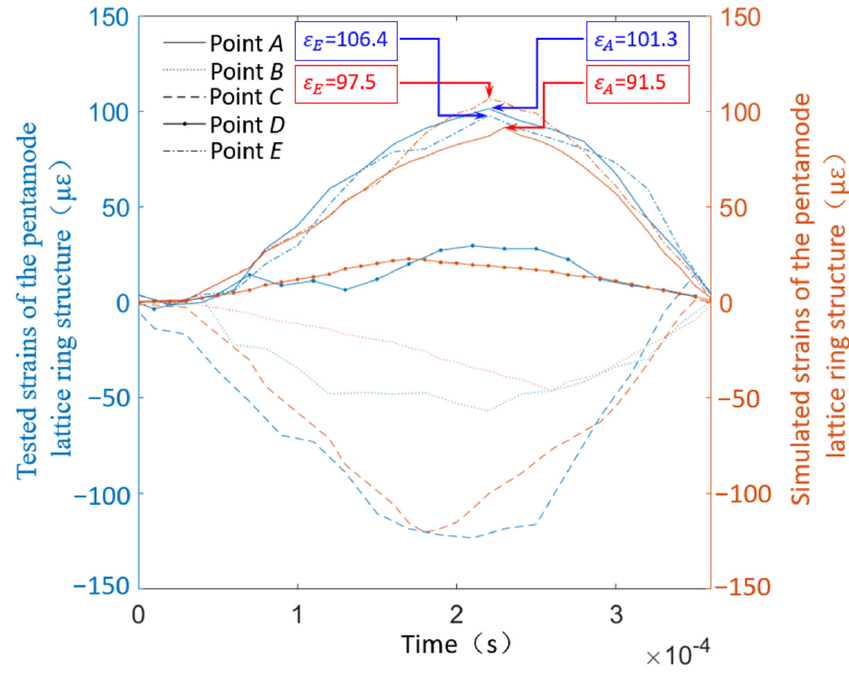
Figure 4. Strain time-history curves of the pentamode lattice-ring structure. Table 2. Peak strains and protection performance parameters.